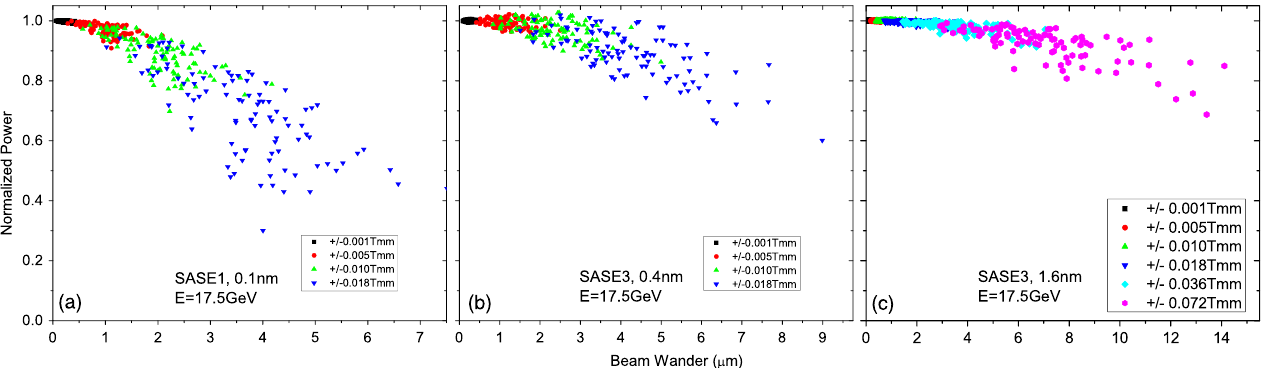
FIG. 3. G ENESIS 1.3 simulations at different wavelengths with a 17.5 GeV beam. The normalized power is plotted against rms beam wander caused by different first field integral kicks on the phase shifter positions. (a) SASE 1 or 2 at 0.1 nm; (b) SASE3 at 0.4 nm; (c) SASE3 at 1.6